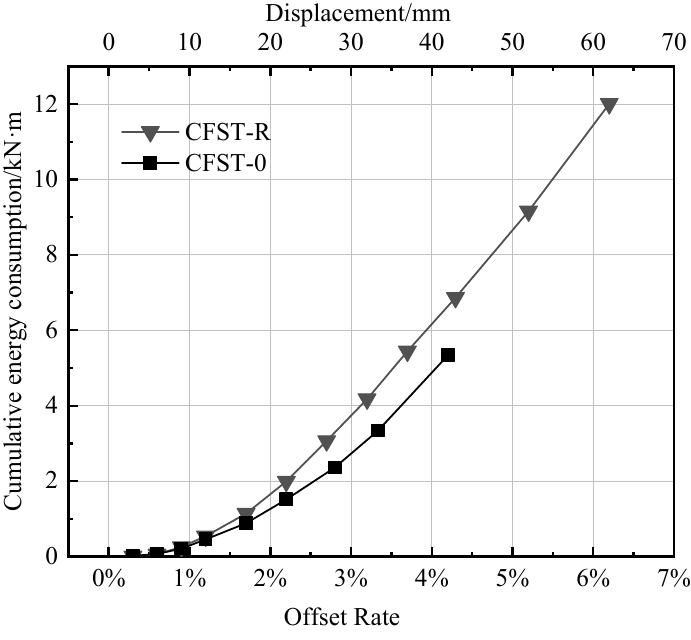
Figure 17. Cumulative energy consumption capacity.